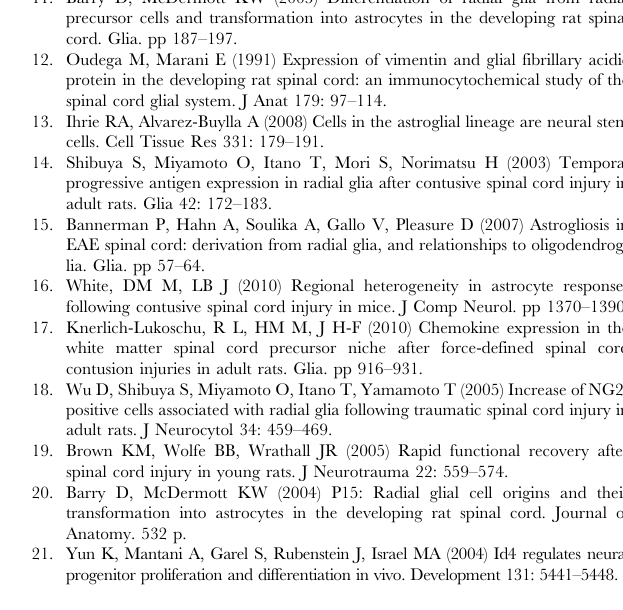
adult SC. Immuno-positive multipolar cells and BV are included here. Arrow: process; double arrowhead: double-positive cell; double arrow: SCRG; dotted line: marginal edge of SC; BV: blood vessels. Scale bars: 50 m m (TIF) Table S1 List of genes expressed by spinal cord radial glia. The genes listed here have a distinct SCRG expression pattern, and were identified using the ASCA and testing within the ASCA for known neural stem cell genes. The ISH record for each gene was independently analyzed and assigning a score between 0–3 for both the neonatal and adult time points (for examples see Figure S1). The ontological categories assigned to each of the genes were determined using DAVID. (XLS) Table S2 List of Core Genes Expressed by SCRG, CC and SVZ Cells. The nine genes that are shared between SCRG, the CC and SVZ progenitor populations are listed here. The gene symbols and official gene names are given along with their Entrez Gene summary, from the NCBI website (National Center for Biotechnology; http://www.ncbi.nlm.nih.gov/entrez). Asterisks mark genes associated with human disease, as listed on OMIM (Online Mendelian Inheritance in Man; http://www.ncbi.nlm. nih.gov/omim) website (excluding Lxn ; (Muthusamy et al., 2006), with the corresponding disease listed after the gene